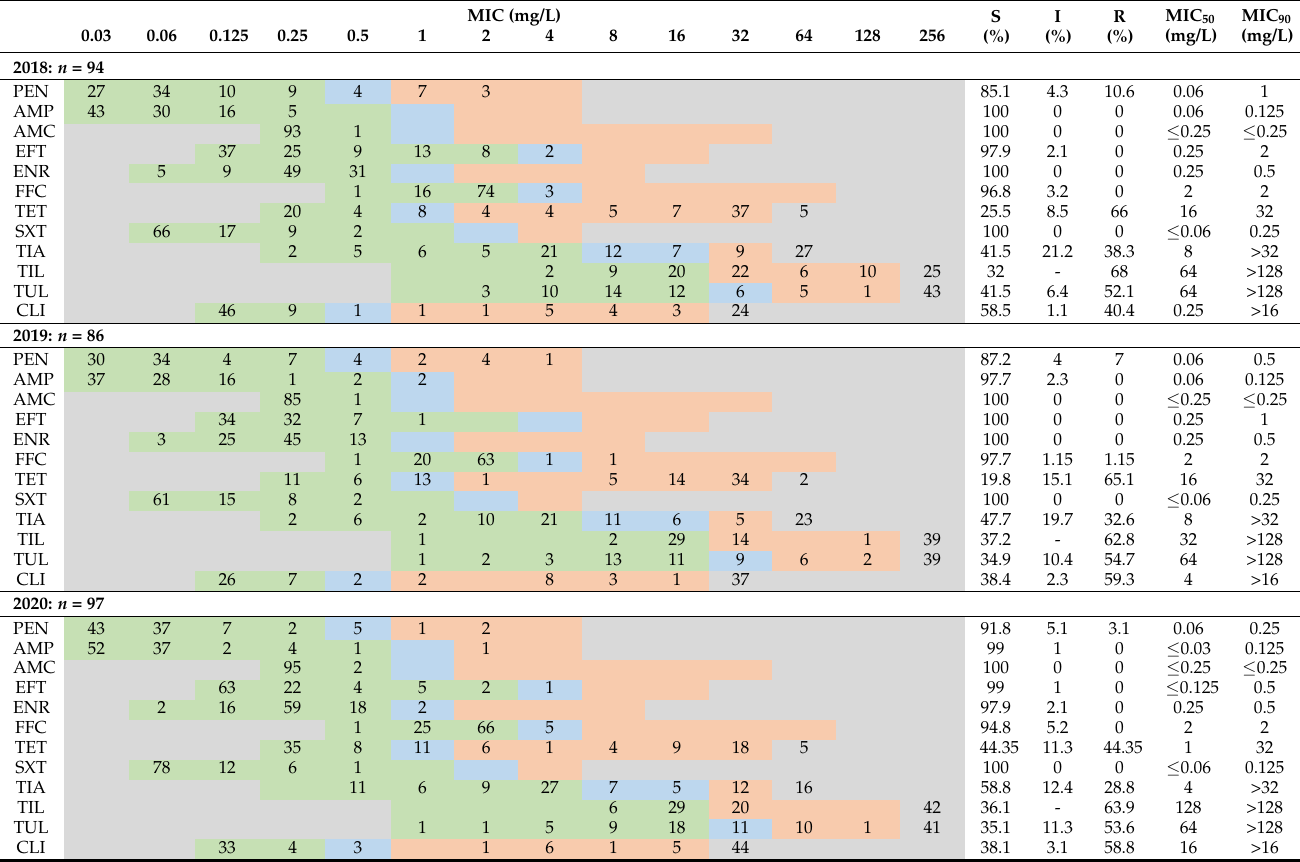
Figure 1. The prevalence of serotypes of S. suis isolates from Czech farms in 2018–2022. NT = Non- typeable isolates. Table 1. MICs distribution for antimicrobials; percentages of susceptible, intermediately resistant, and resistant isolates, and MIC 50 and MIC 90 values in S. suis isolates from Czech farms in